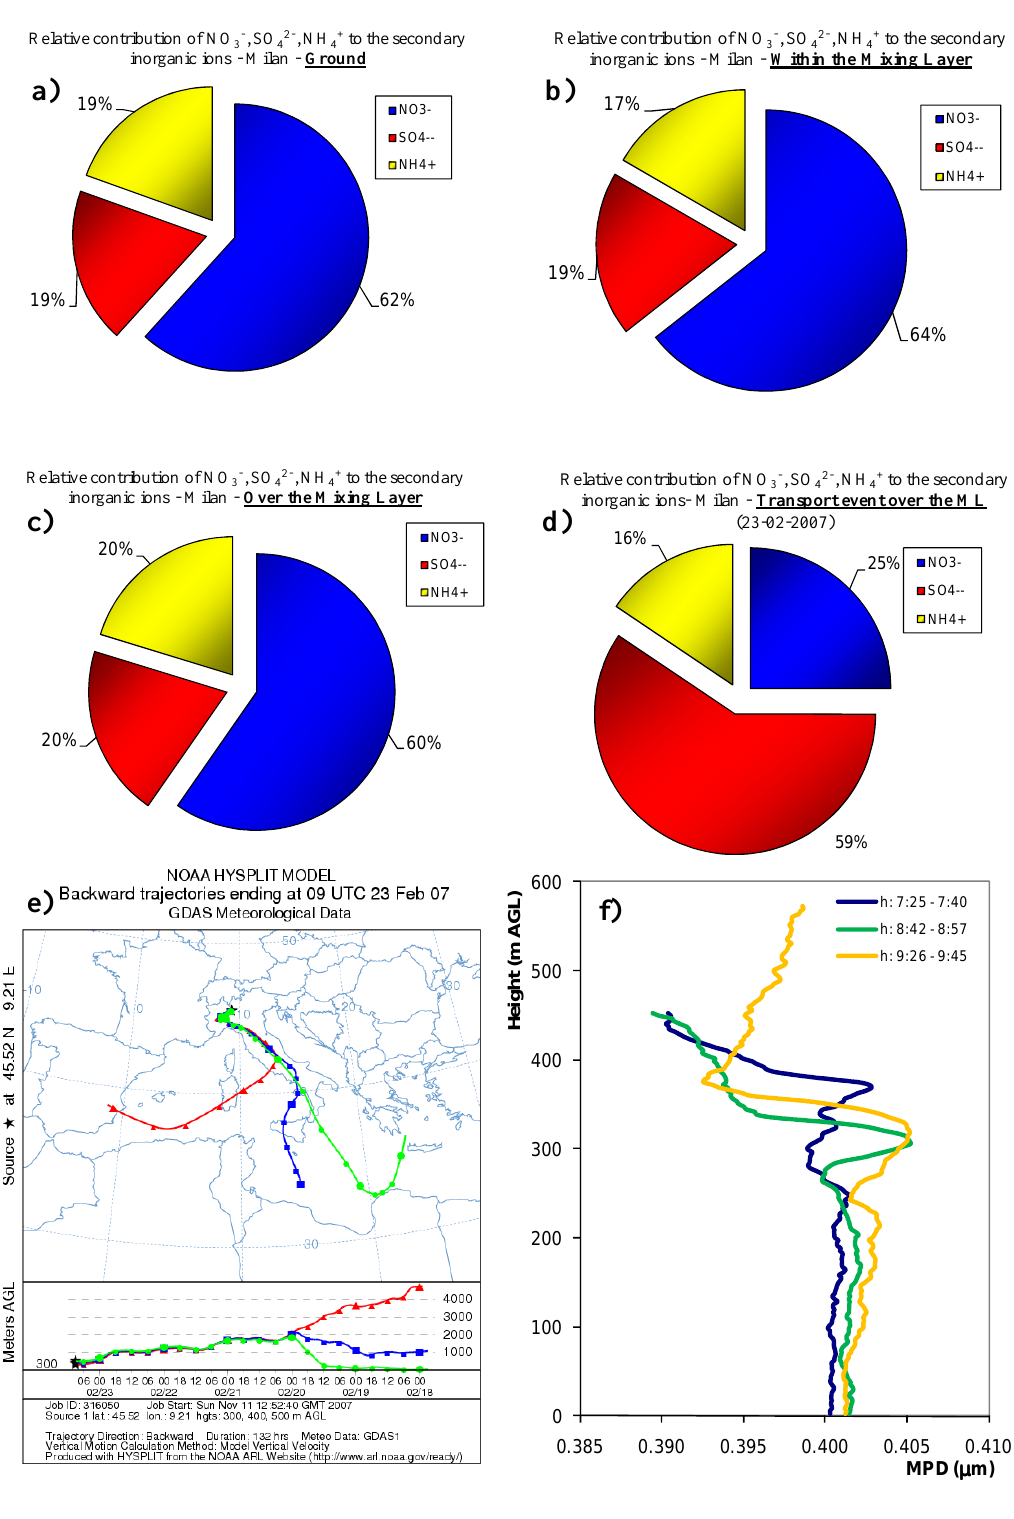
Fig. 10. Percentages of NO − , SO 2 − and NH + compared to their total, measured in Milan at ground-level (a) , within the ML (between 3 4 4 ground and mixing height) (b) and above it (c) when an increase in MPD was observed in the fine fraction ( d p < 1.6µm). Panel (d) shows relative values of NO − , SO 2 − and NH + during the transport event of 23 rd February 2007. Back trajectories and MPD during the transport 3 4 4 event are shown in panels (e) and (f)